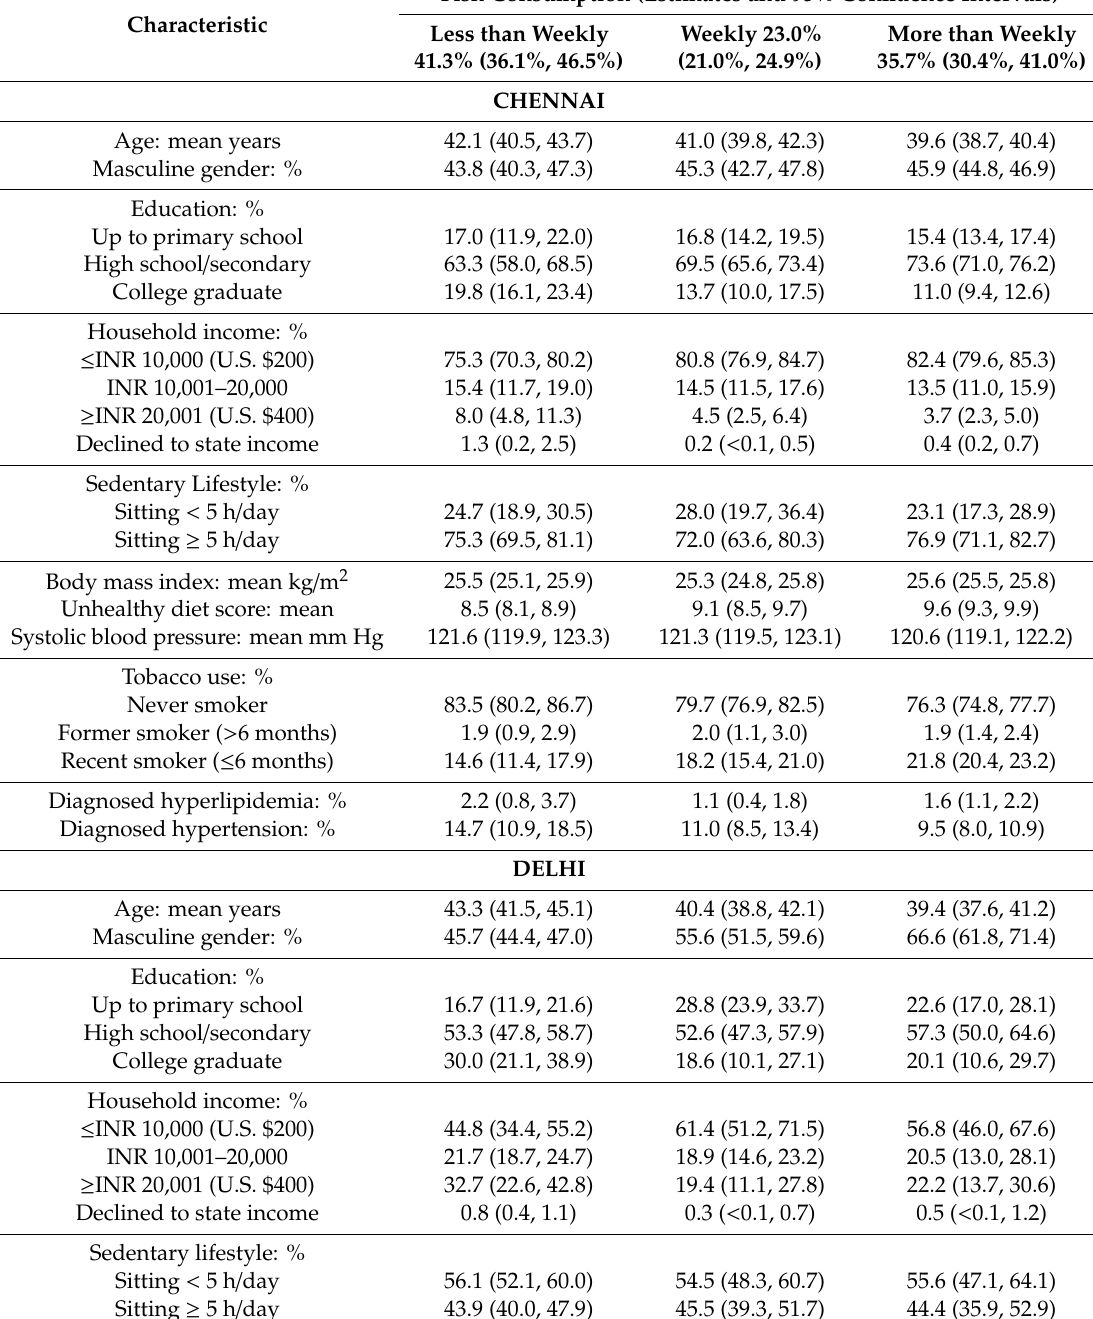
Table 1. Estimated population characteristics, by city and fish consumption. Survey estimation techniques were used to obtain estimates of population means and proportions. Here, the category “less than weekly” indicates that fish is consumed monthly or never. Disjoint categories within a column, within each city, sum to 100% (with rounding). Statistics are estimates for the characteristics of each city’s population of permanent residents age ≥ 20 years old, who are neither pregnant nor on bedrest. Population parameter estimates are based on a large survey sample including participants from Karachi (unweighted n = 4017), Delhi (unweighted n = 5364), and Chennai (unweighted n = 6906). U.S.—United States; INR—Indian